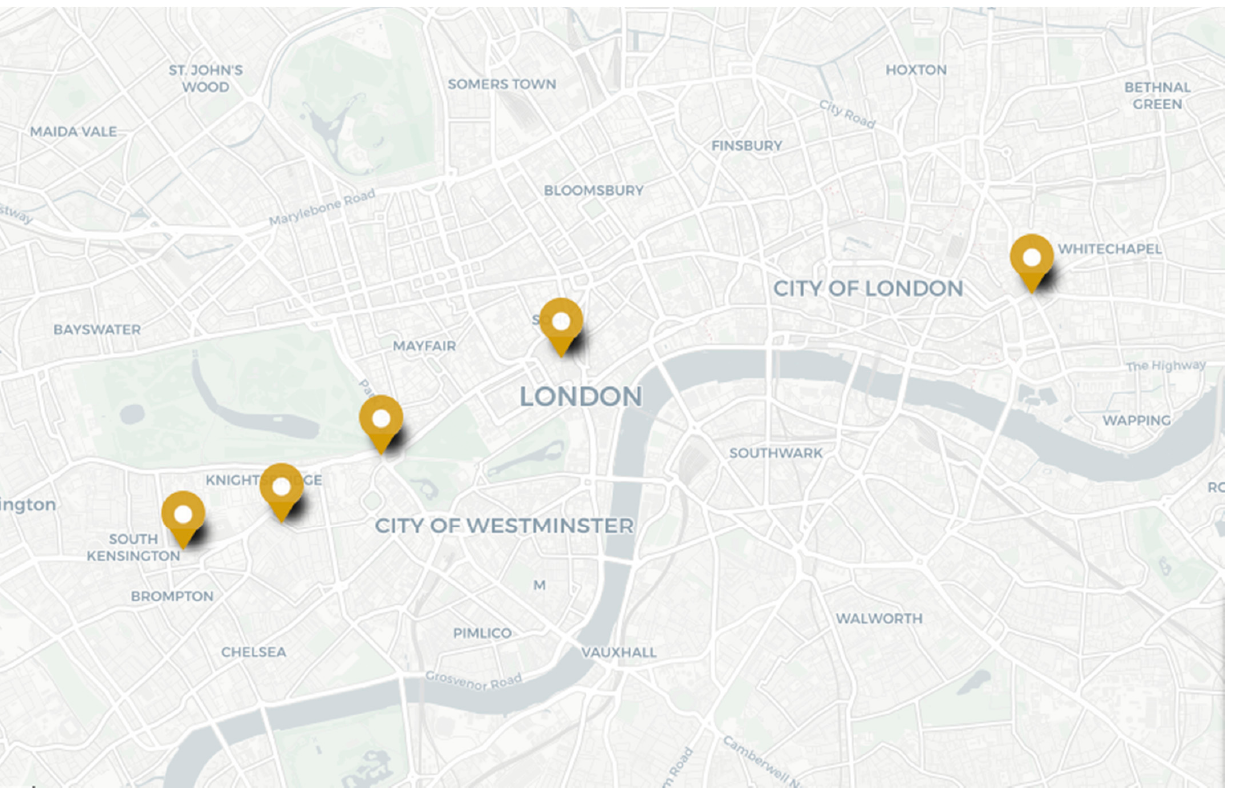
Figure 6. Map of the LSN recording locations.